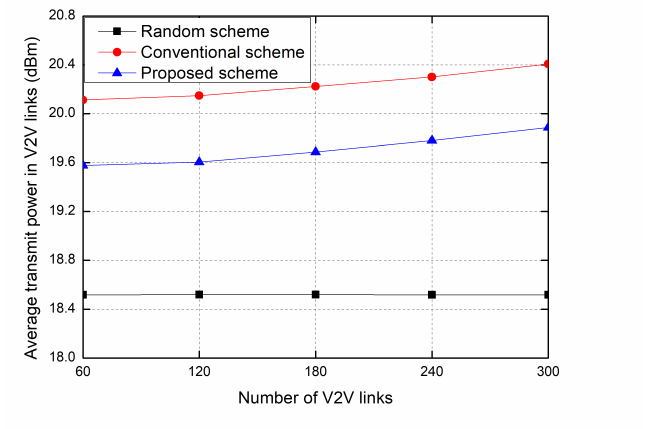
Figure 5. Average transmit power of V2V